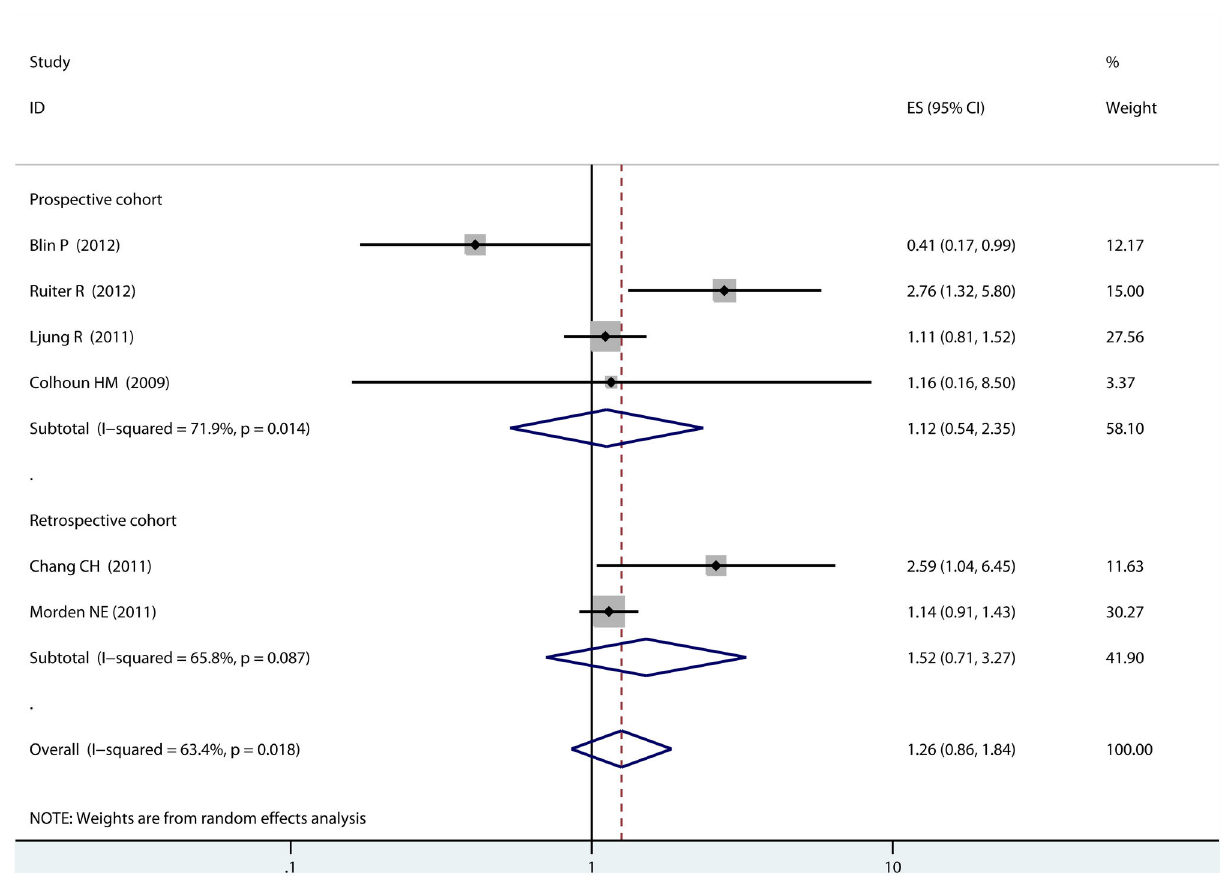
Figure 3. Forest plot: comparison of insulin glargine vs. non-glargine insulins and risk of prostate cancer. doi: